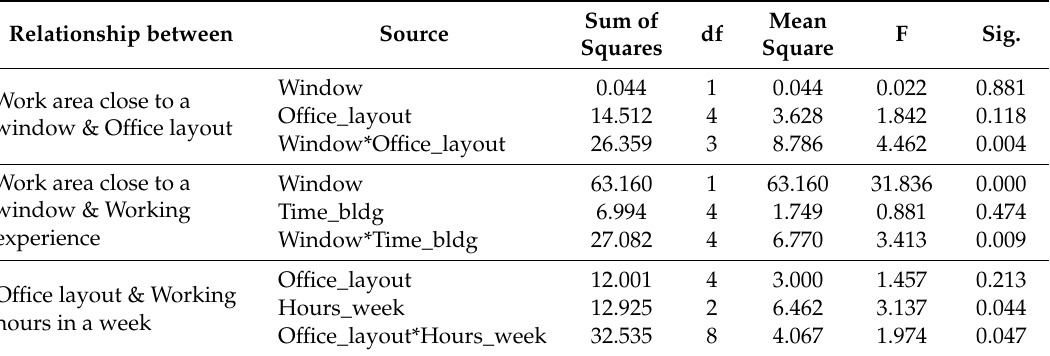
Table 6. Results of two-way ANOVA tests done for